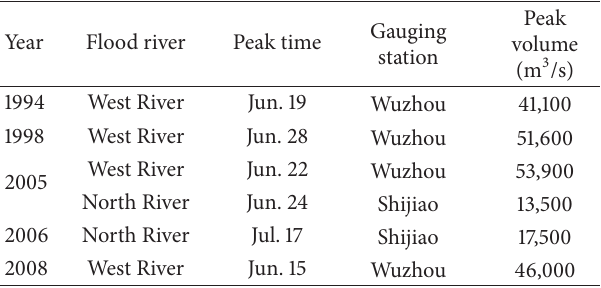
Table 1: Big floods in the past 20 years in Pearl River